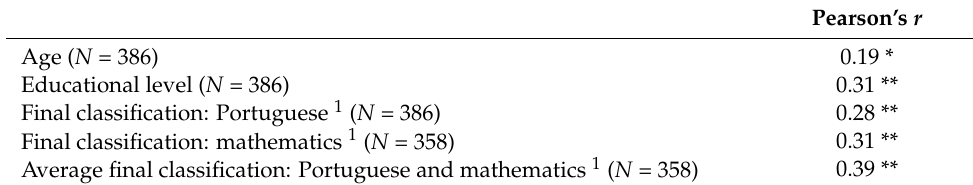
Table 5. Convergent validity of the NVS-PTeen assessed as the correlation between theoretically related variables and the NVS-PTeen total score.